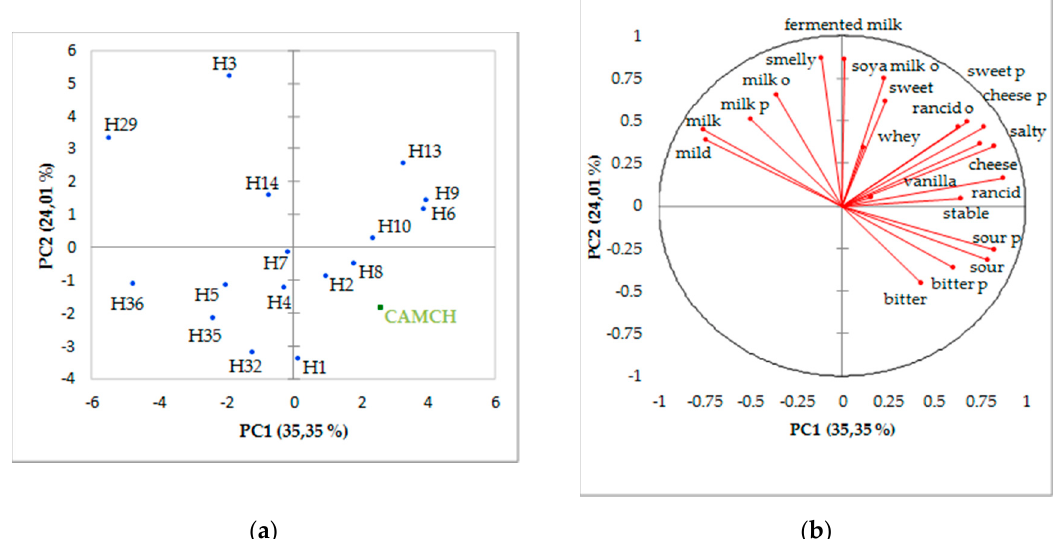
Figure 2. Principal component analysis (PCA) and correlation circle for principal components 1 and 2: ( a ) hydrolysates of milk protein liquid fraction enriched in micellar caseins (ratio micellar caseins / whey proteins (92:8)); ( b ) hydrolysate descriptors. A commercially available milk casein hydrolysate (CAMCH) was projected as supplementary observation.